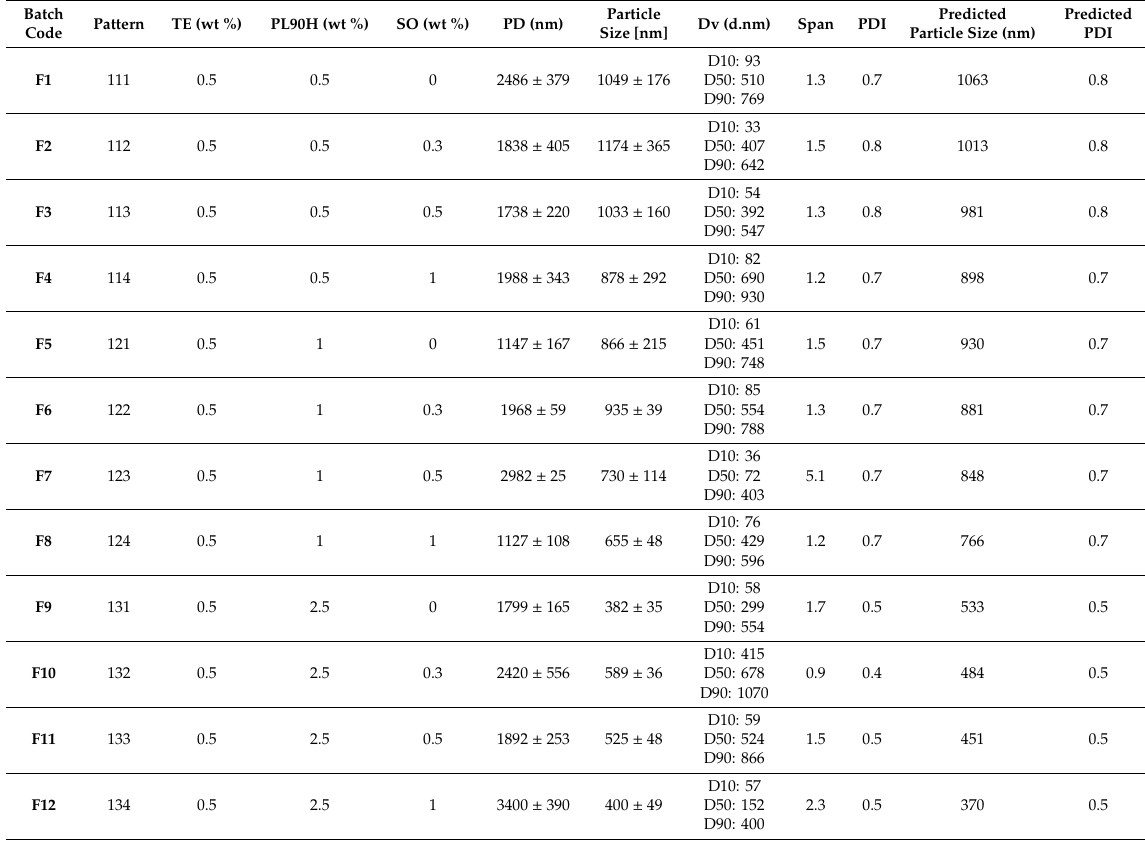
Table 3. Observed and predicted particle size and polydispersity index values of aqueous TE dispersions measured using Zetasizer, (Mean ± SD, n = 3). PD: pre-dispersion, PDI: polydispersity